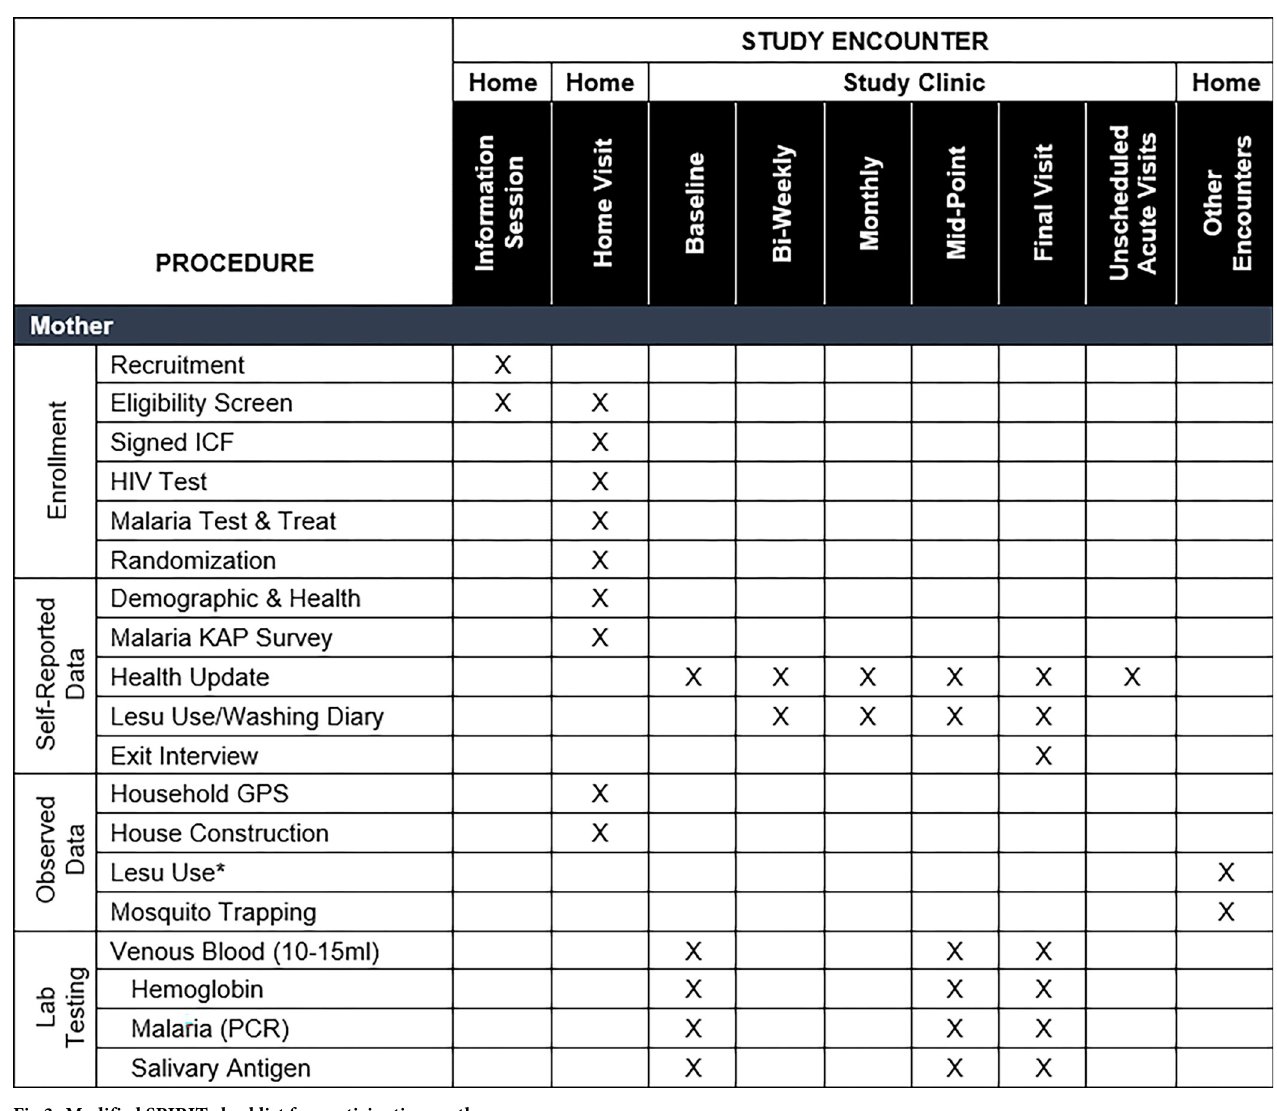
Fig 3. Modified SPIRIT checklist for participating